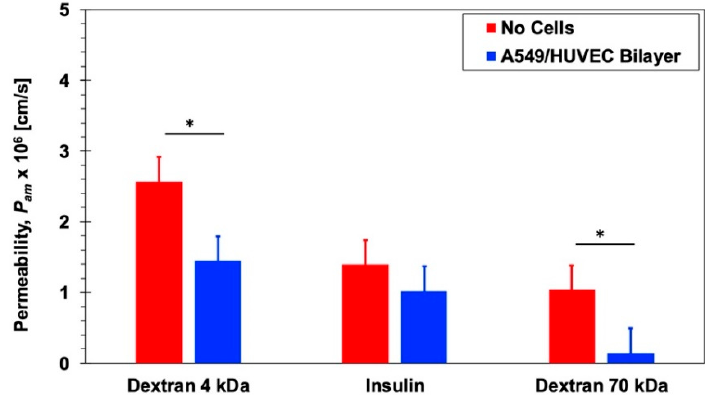
Figure 4. Permeability of 4-dextran, 70-dextran, and insulin in microfluidic bilayer devices with and without an epithelial / endothelial barriers. Significance determined with student’s T -test with unequal variance (n = 3); * p < 0.05.